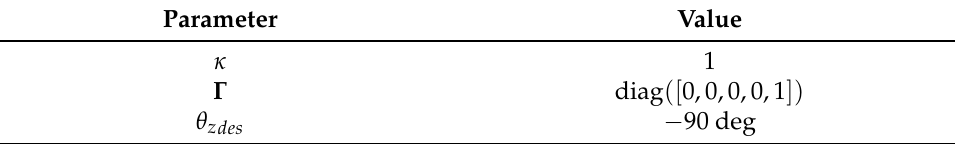
Table 3. GCMG steering law